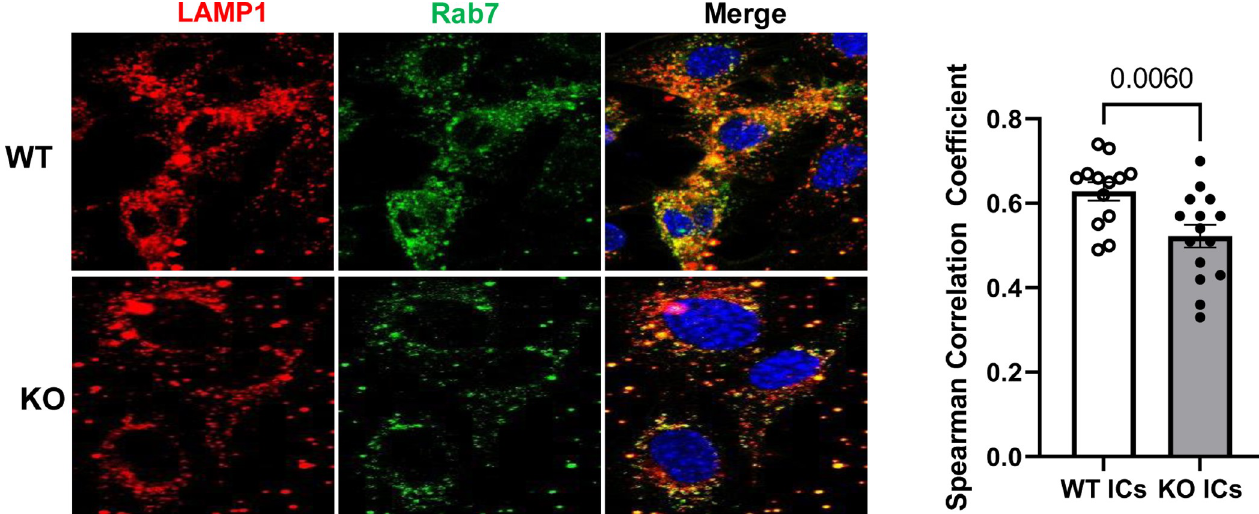
Fig 3. FcRn KO significantly reduces colocalization between late endosomal and lysosomal compartments after treatment with ICs. Late endosomes are Rab7+ and are stained red. Lysosomes are LAMP1 positive and are stained green. Each point on the graph represents the average correlation coefficient for 3–5 cells from n = 3 independent